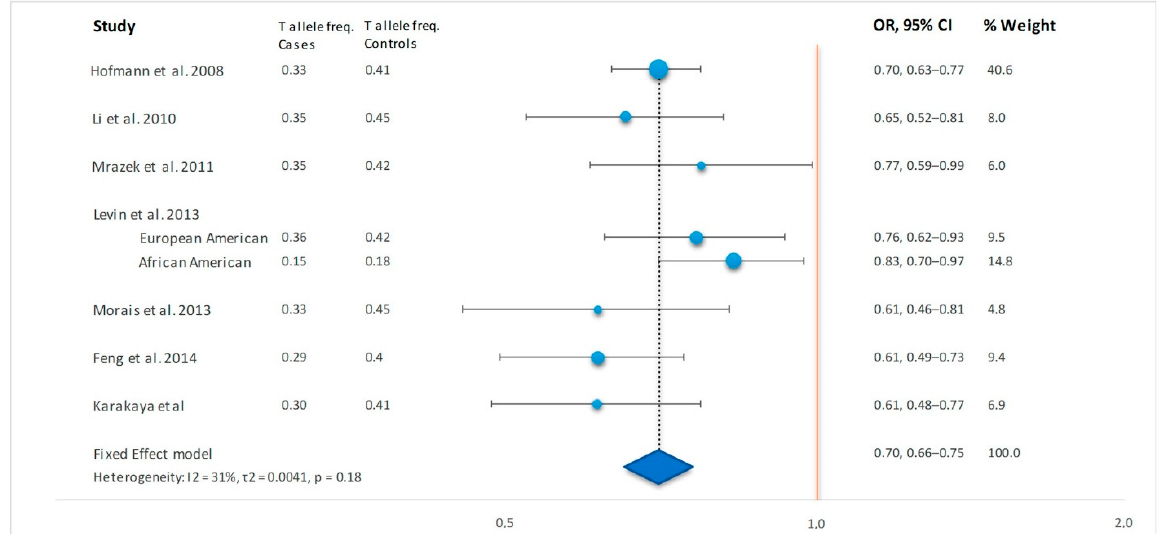
Figure 1. Meta-analysis for the studies of ANXA11 with sarcoidosis. Forest plot of the odds ratio for ANXA11 rs1049550 T allele in sarcoidosis cases versus controls. For correct presentation, the C and T allele are switched for the studies of Levin et al. Dotted line represents the odds ratio from the combined analysis. The result of the meta-analysis is presented as a diamond at the bottom that covers the combined OR in the middle and the CI at the tips. OR: Odds ratio, 95% CI: 95% confidence interval.